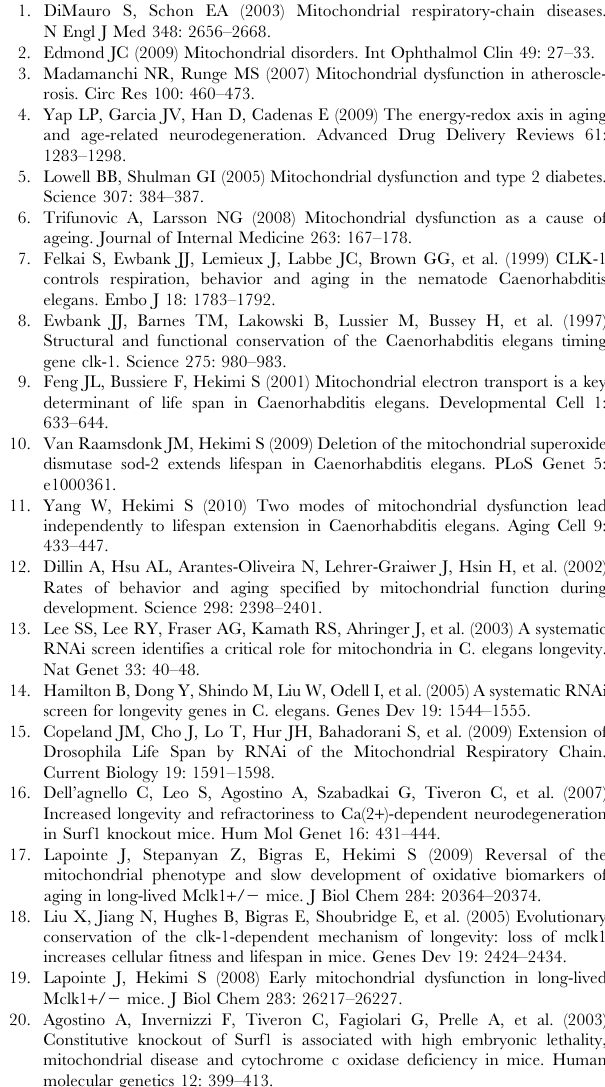
Table S3 State 4 and respiratory control ratios. (XLS) Figure S1 Graphical depiction of the Gompertz param- eters A and k . ( A ) Intrinsic vulnerability to death ( A ) for females (F) and males (M). ( B ) Mortality rate acceleration ( k ) for females (F) and males (M). For both (A) and (B), the standard error is derived from the nonlinear fit of the Gompertz survival